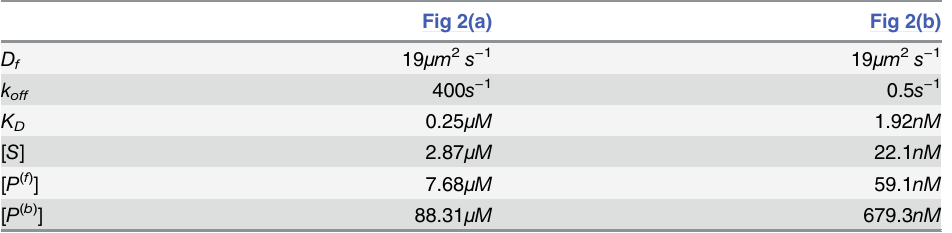
Table 2. Parameters used in the stochastic simulations. The parameters of the first column were derived in [10] from an analysis of FCS experiments performed in Drosophila embryos. Those of the second column were chosen